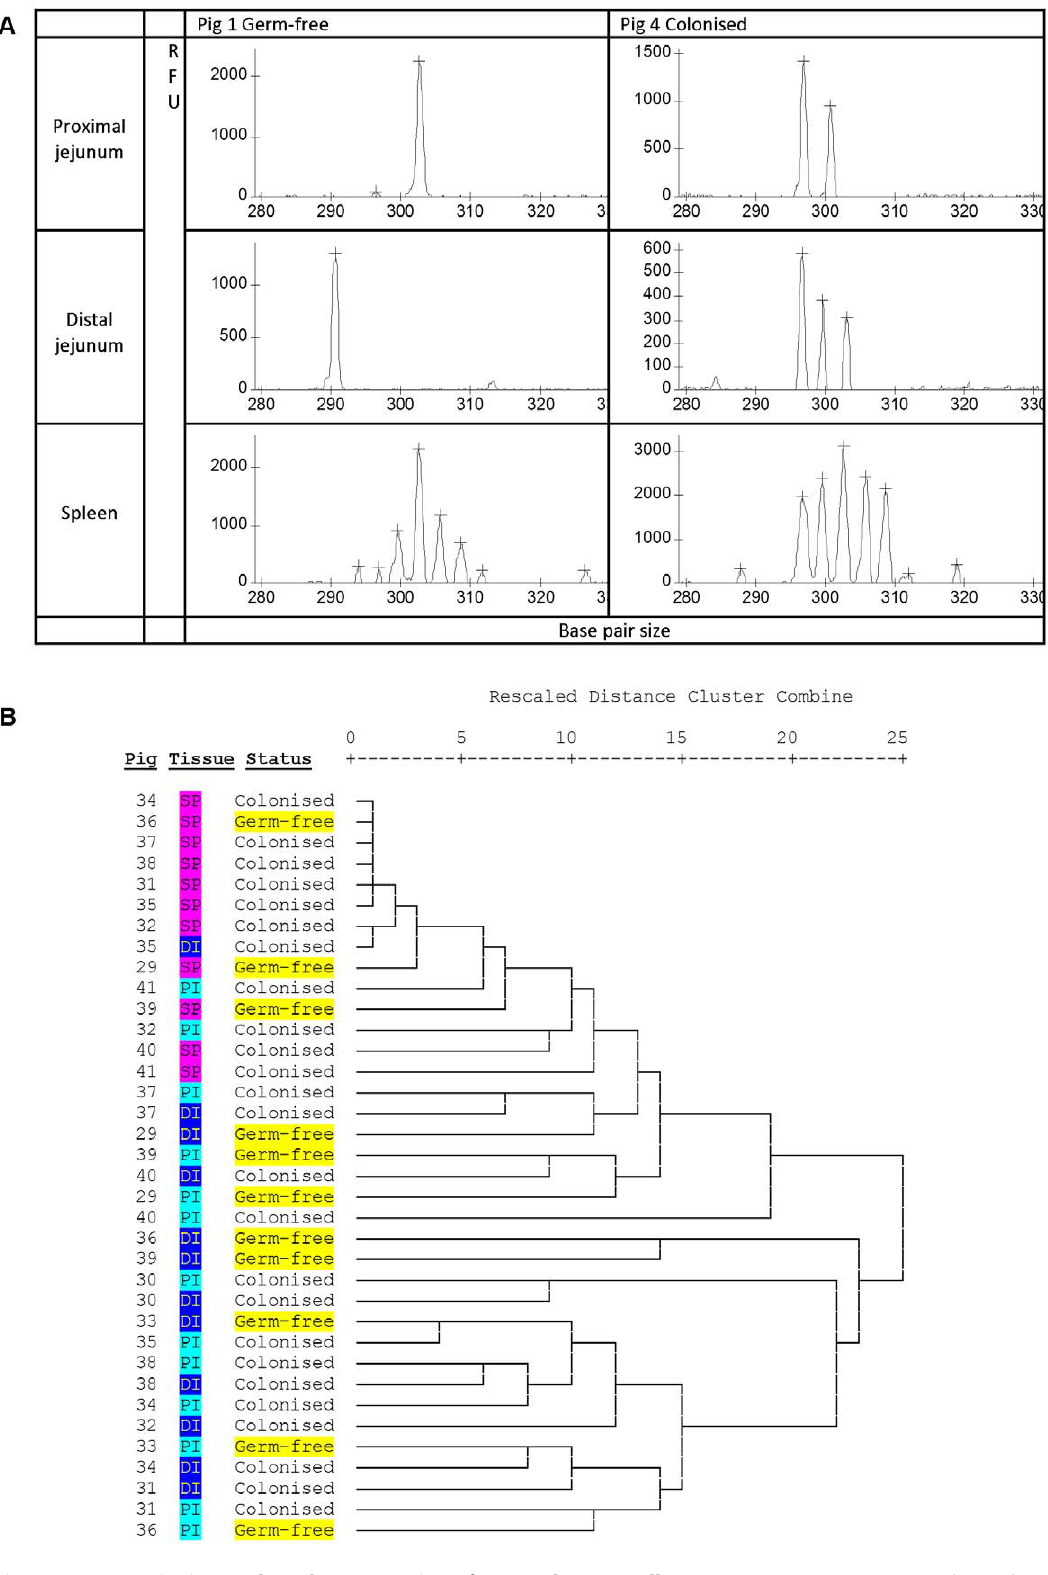
Figure 3. Repertoire is not altered on expansion of mucosal CD4 T-cells. (A) Representative spectratype electropherograms of TR b V 29 for a germ-free pig, and a colonised pig from the same litter of piglets. In general, samples from the spleen demonstrate a more Gaussian electropherogram distribution than intestinal samples. RFU: relative fluorescence units, x axis: CDR3 length (base pair size). (B) Hierarchical cluster analysis of CDR3 lengths from 20 TR b V groups and 1 subgroup from the proximal jejunum, distal jejunum and spleen from pigs at 21 days of age.